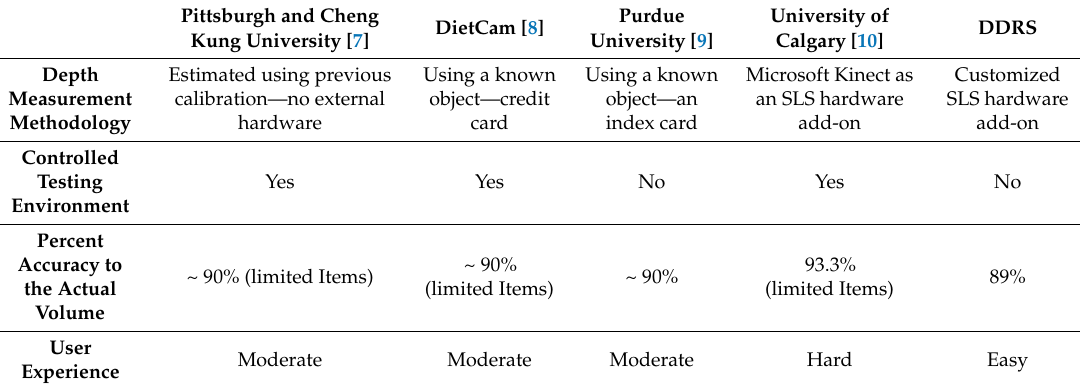
Table 1. Comparison between the current food volume estimation methods and the